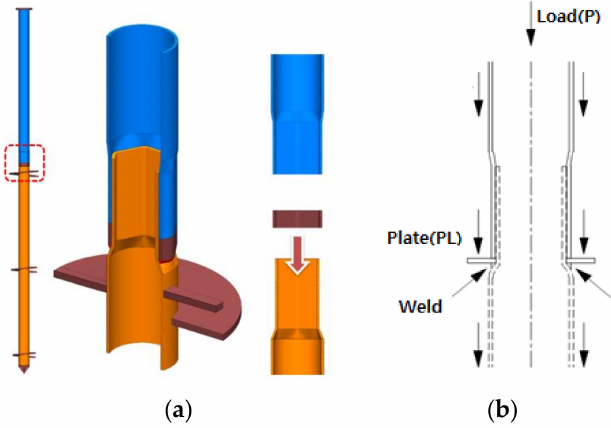
Figure 2. Designing hexagonal joint: ( a ) Hexagonal joint model; ( b ) Concept of load transfer.